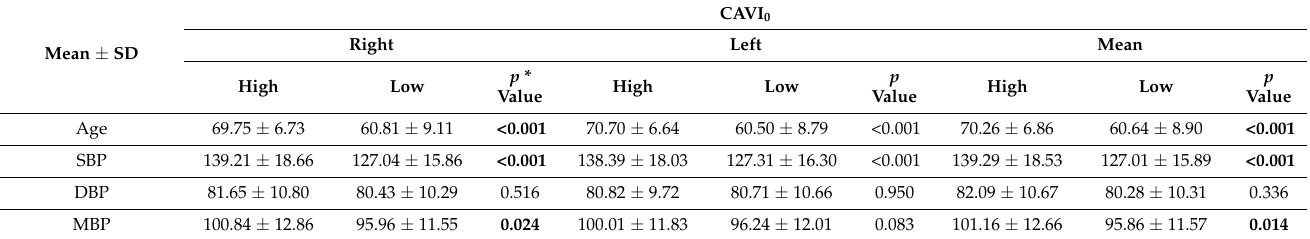
Table 3. Distribution of age and blood pressure indices based on high and low values of right, left, and mean CAVI 0